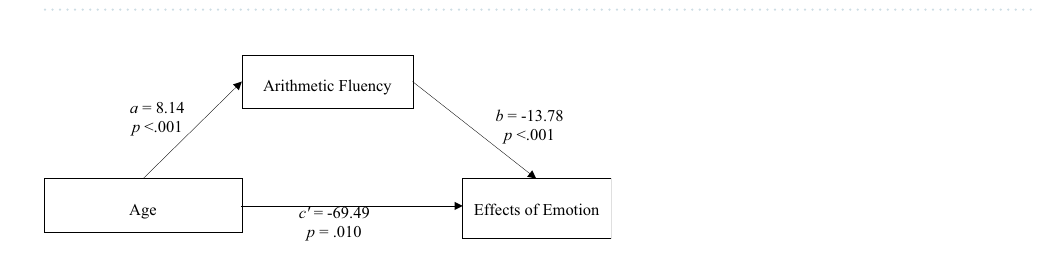
Figure 2. Distributions of emotion effects (delta plots) in each age. This plot shows how the size of emotion effects (differences in latencies between emotion and neutral conditions) varies as a function of the overall distribution of latencies for the 1st, 2nd, 3rd, and 4th quartiles.